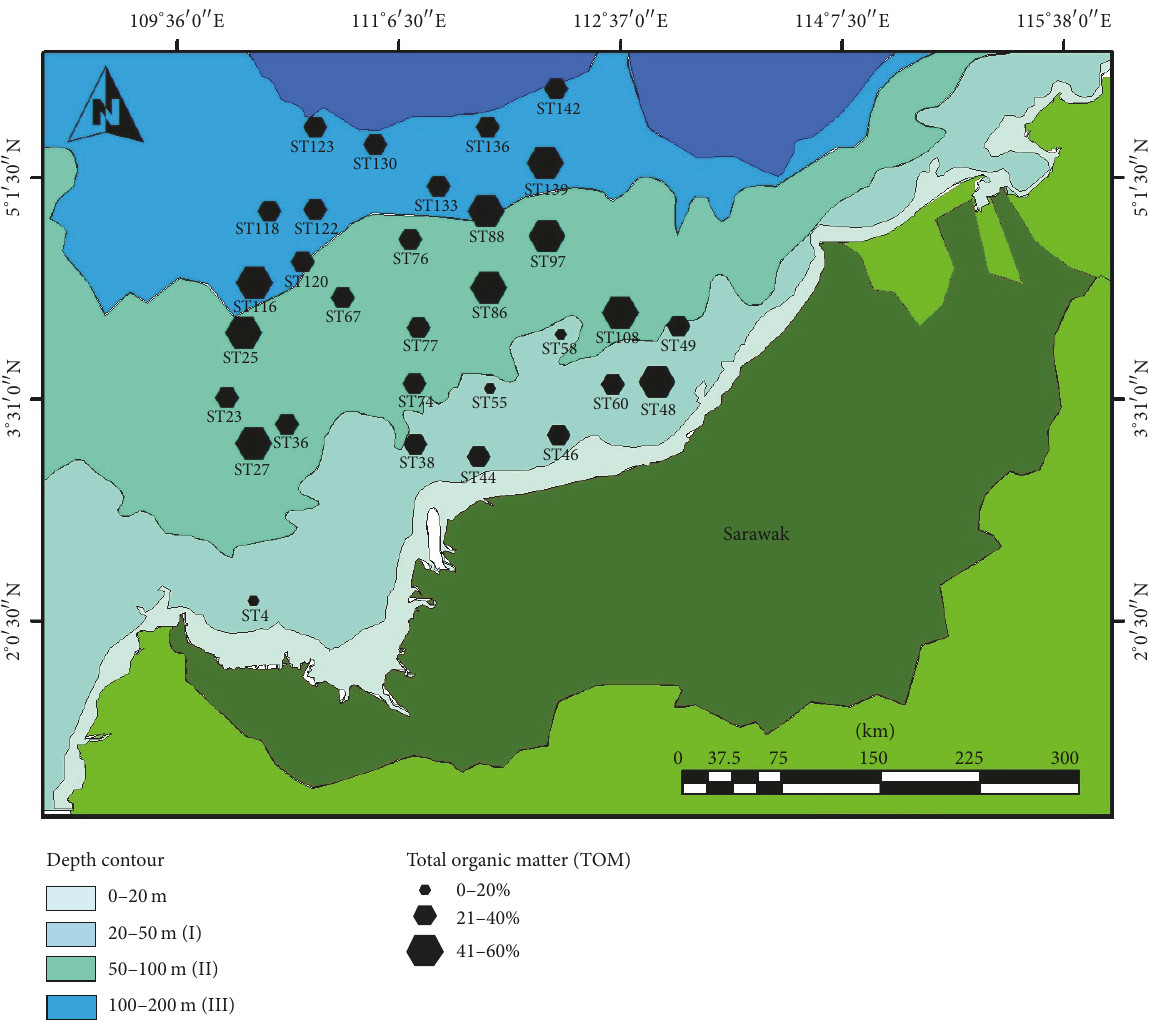
Figure 3: Amount (%) of TOM at 31 stations in the continental shelf of